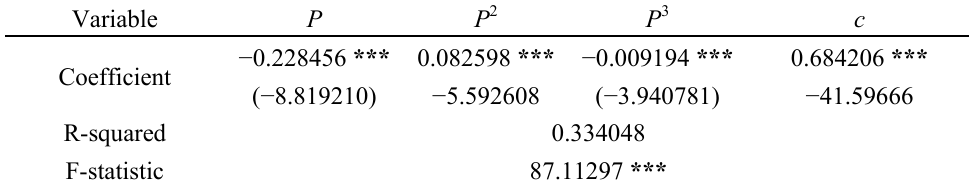
Table 4. Estimation results from the panel random effects